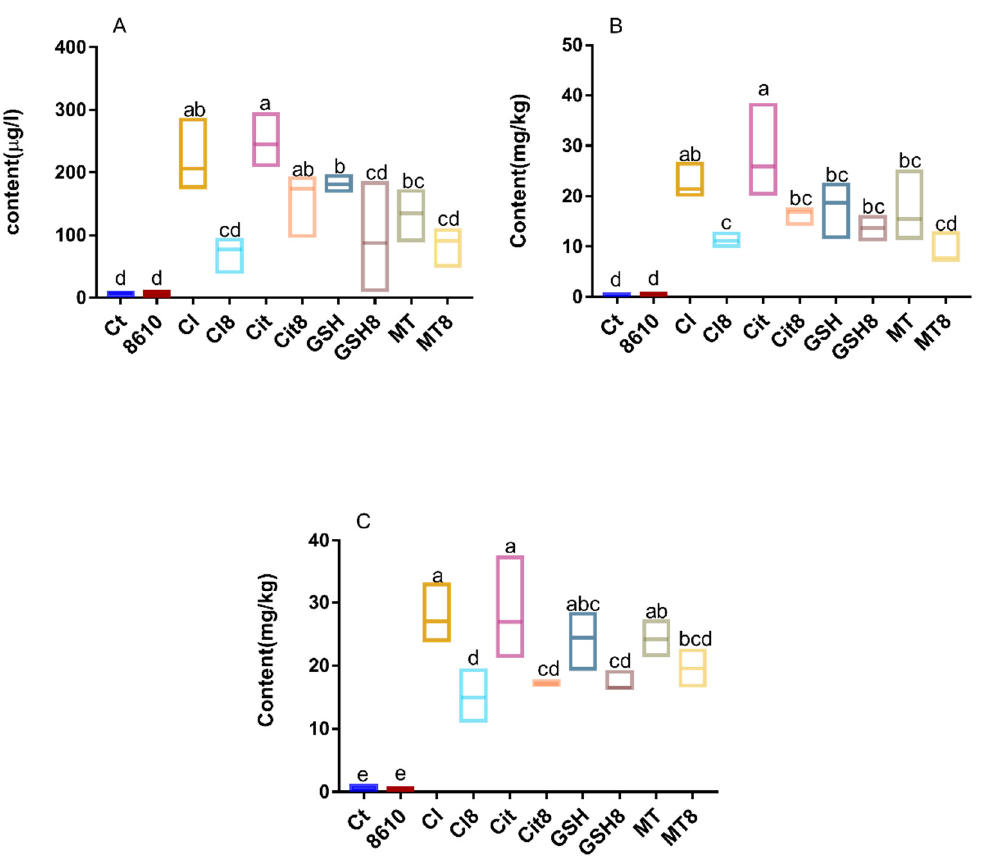
Figure 1. Changes in cadmium content in the blood ( A ), liver ( B ), and kidneys ( C ) of mice. Ct, Control; 8610, CCFM8610 treatment only; Cl, CdCl 2 ; Cl8, CdCl 2 + CCFM8610; Cit, Cd–citrate; Cit8, Cd–citrate + CCFM8610; GSH, Cd–glutathione (Cd–GSH); GSH8, Cd–GSH + CCFM8610; MT, Cd–Metallothionein (Cd–MT); MT8, Cd–MT + 8610. Different small letters in the figures indicate significant differences at p < 0.05. See also in following figures.